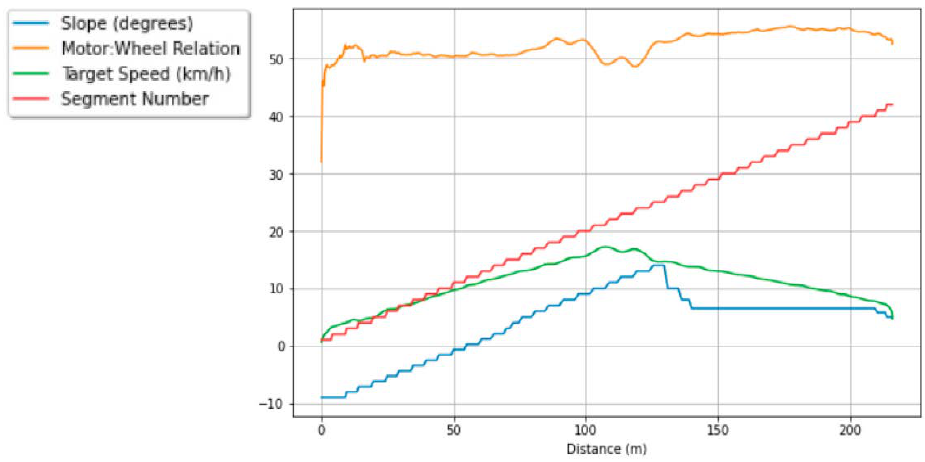
Figure 9. Test route data.